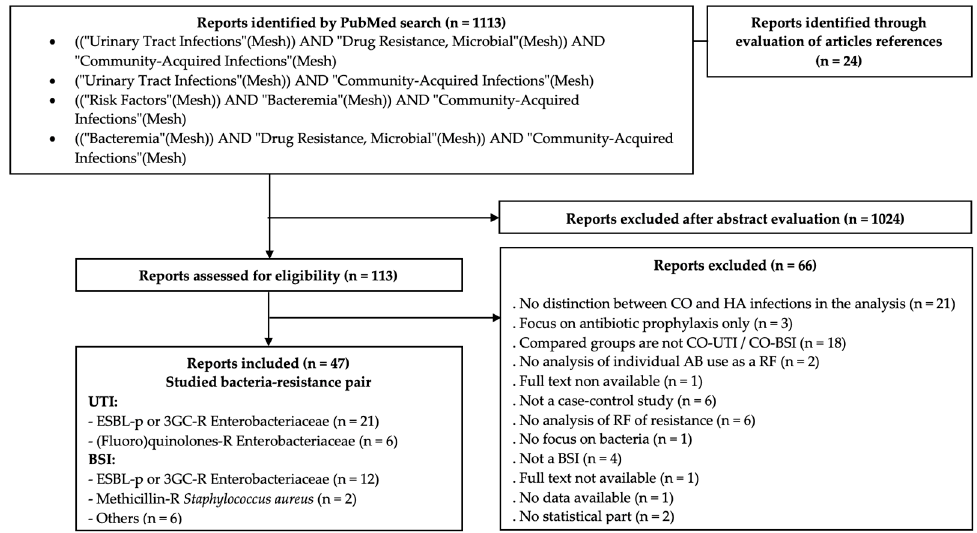
Figure 2. Flowchart of the selection process of case–control studies assessing the risk factors of re- sistance in bloodstream and urinary tract infections. Abbreviations: 3GC = third generation cepha- losporins; AB = antibiotic; BSI = bloodstream infections; CO = community-onset; ESBL-p = Extended- Spectrum β -Lactamase producing; HA = hospital acquired; R = resistant; RF = risk factor; UTI = urinary tract infections.